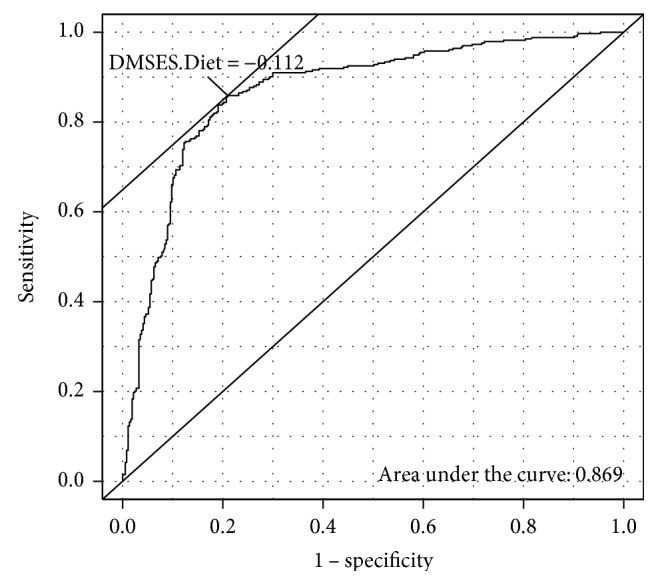
Receiver operating characteristic curve for the diet subscale of T-DMSES against HbA1c control.